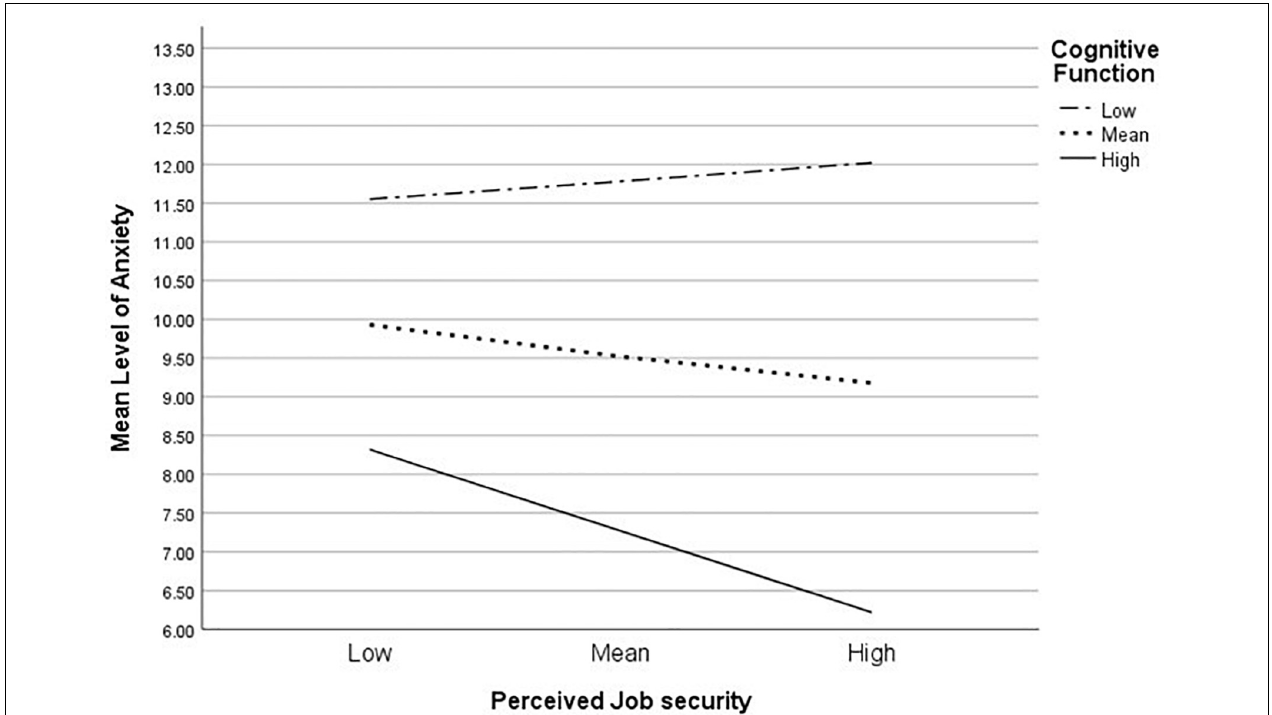
FIGURE 1 | Simple slope equations for the regression of anxiety on job security at three levels of cognitive